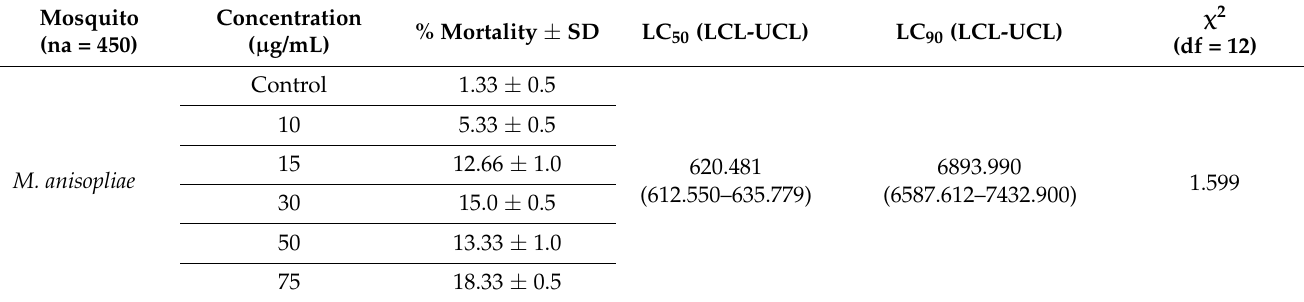
Table 2. Toxicity of M. anisopliae secondary metabolites on A. nauplii at 24 h after treatments. Mosquito